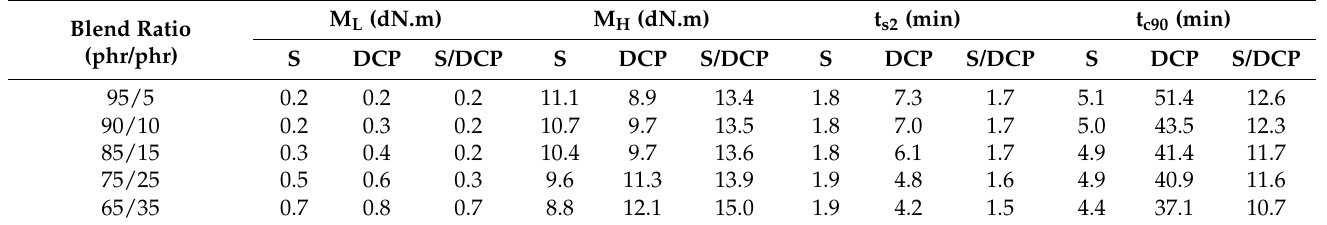
Table 2. Minimum and maximum torques, and scorch and cure times for the NR/r-NBR blends prepared with various crosslinking